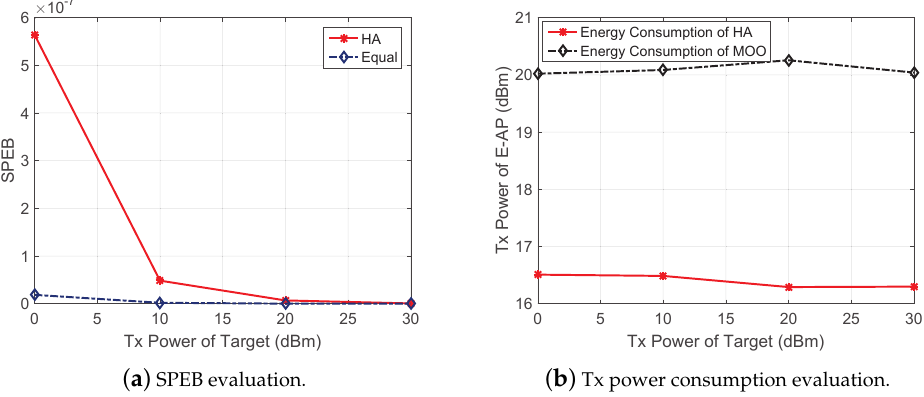
Figure 4. Performance evaluation of different target transmit power using massive deployed